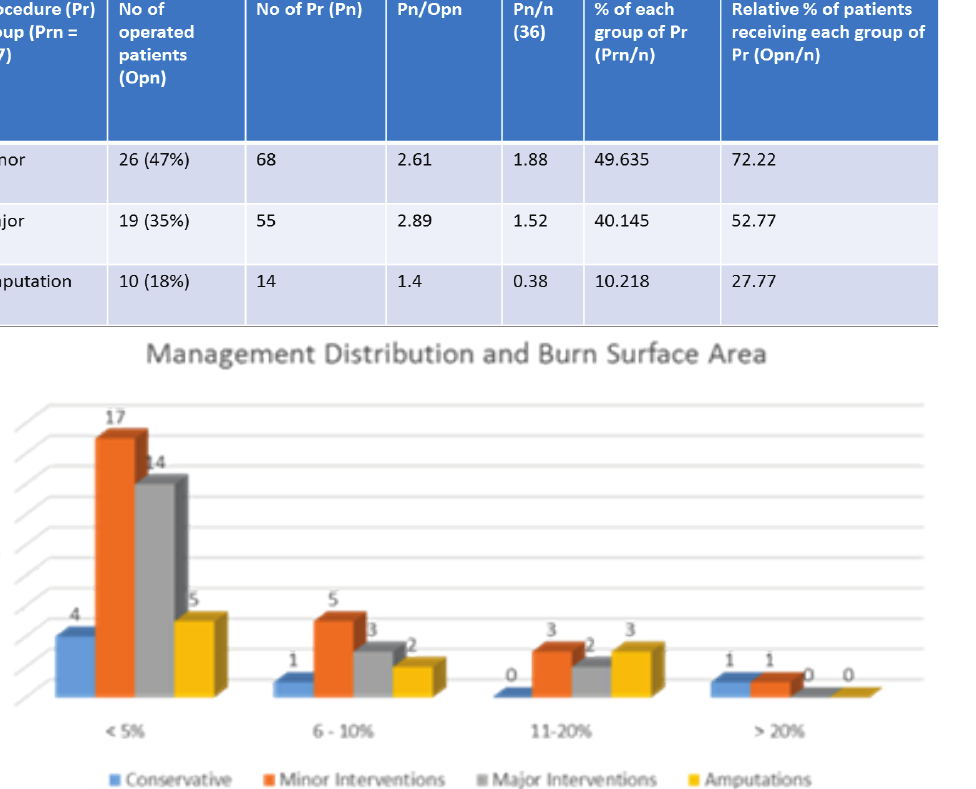
Figure 3: Details of procedures, actual number of operated patients, and their relationship with overall number of